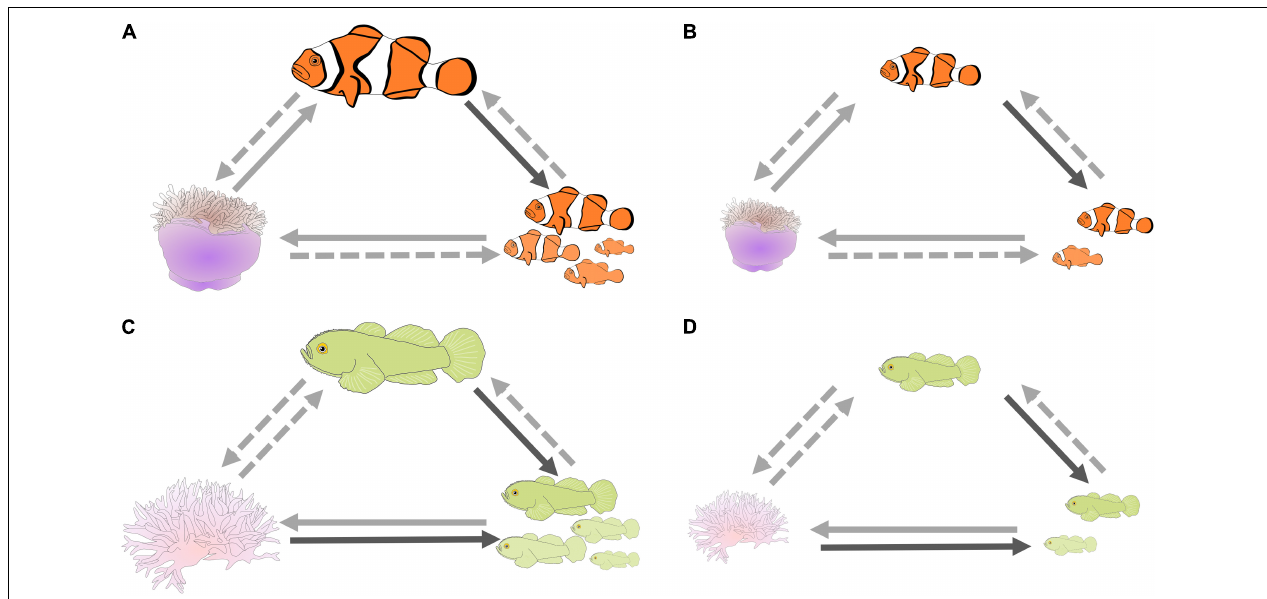
FIGURE 4 | Potential synergistic effects between cnidarian hosts and social coral reef fishes that could help explain why breeders tolerate non-breeders; schematic of the relationships between length of the dominant individual, number of individuals in the group, and size of the cnidarian host for Amphiprion percula – Heteractis magnifica , and Paragobiodon xanthosoma – Seriatopora hystrix ; (A,C) respectively, large host, large dominant breeder and large group, (B,D) small host, small dominant breeder and small group. Dark solid arrows: causality confirmed for the model species; light solid arrows: causality has been confirmed in closely related species; light dashed arrows: causality yet to be confirmed. Note the potential for positive feedback if all three arrows are confirmed clockwise or counterclockwise.